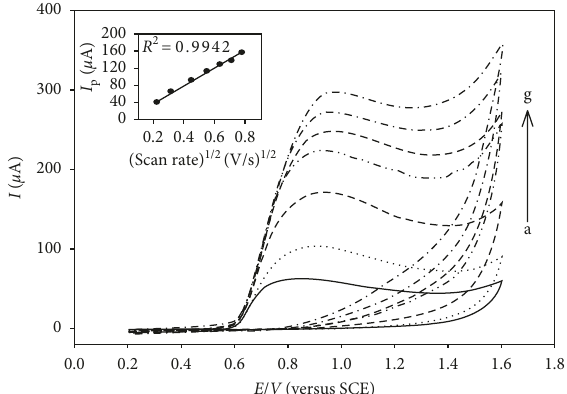
2 M pyridoxine on the glassy carbon Figure 8: CV of 2.0 10 × electrode in the 0.1M phosphate buffer/5 mM NaCl supporting − electrolyte at pH 7.0. Scan rate: (a) 0.05V/s; (b) 0.1 V/s; (c) 0.2V/s; (d) 0.3V/s; (e) 0.4 V/s; (f) 0.5mV/s; (g) 0.6V/s.